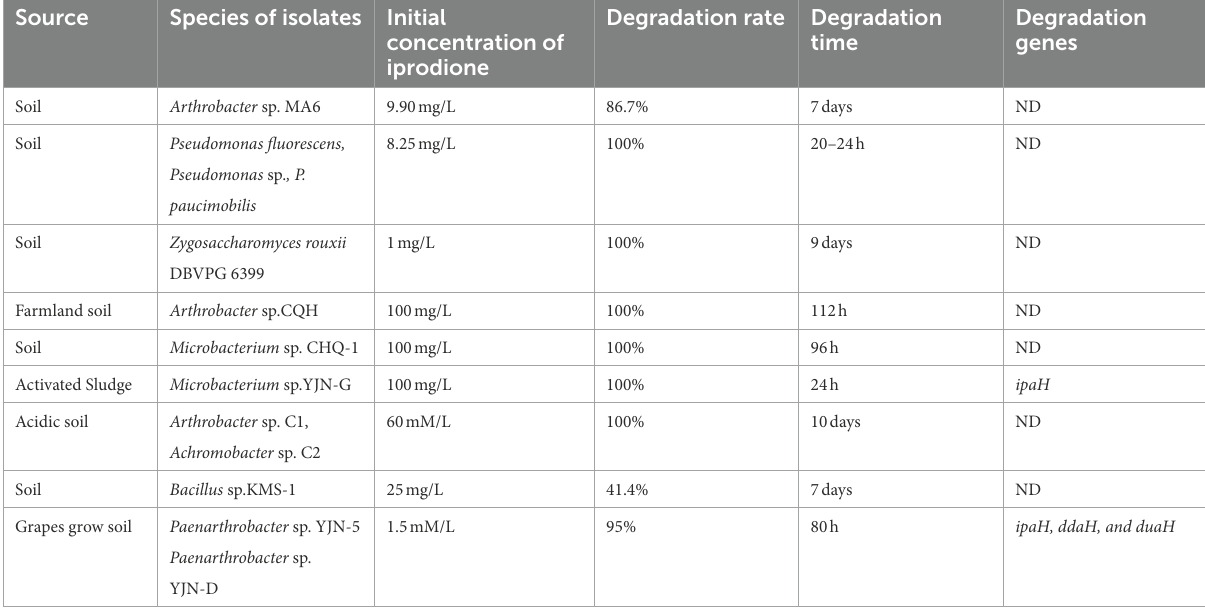
TABLE 2 Basic characteristics of iprodione-degrading strains.